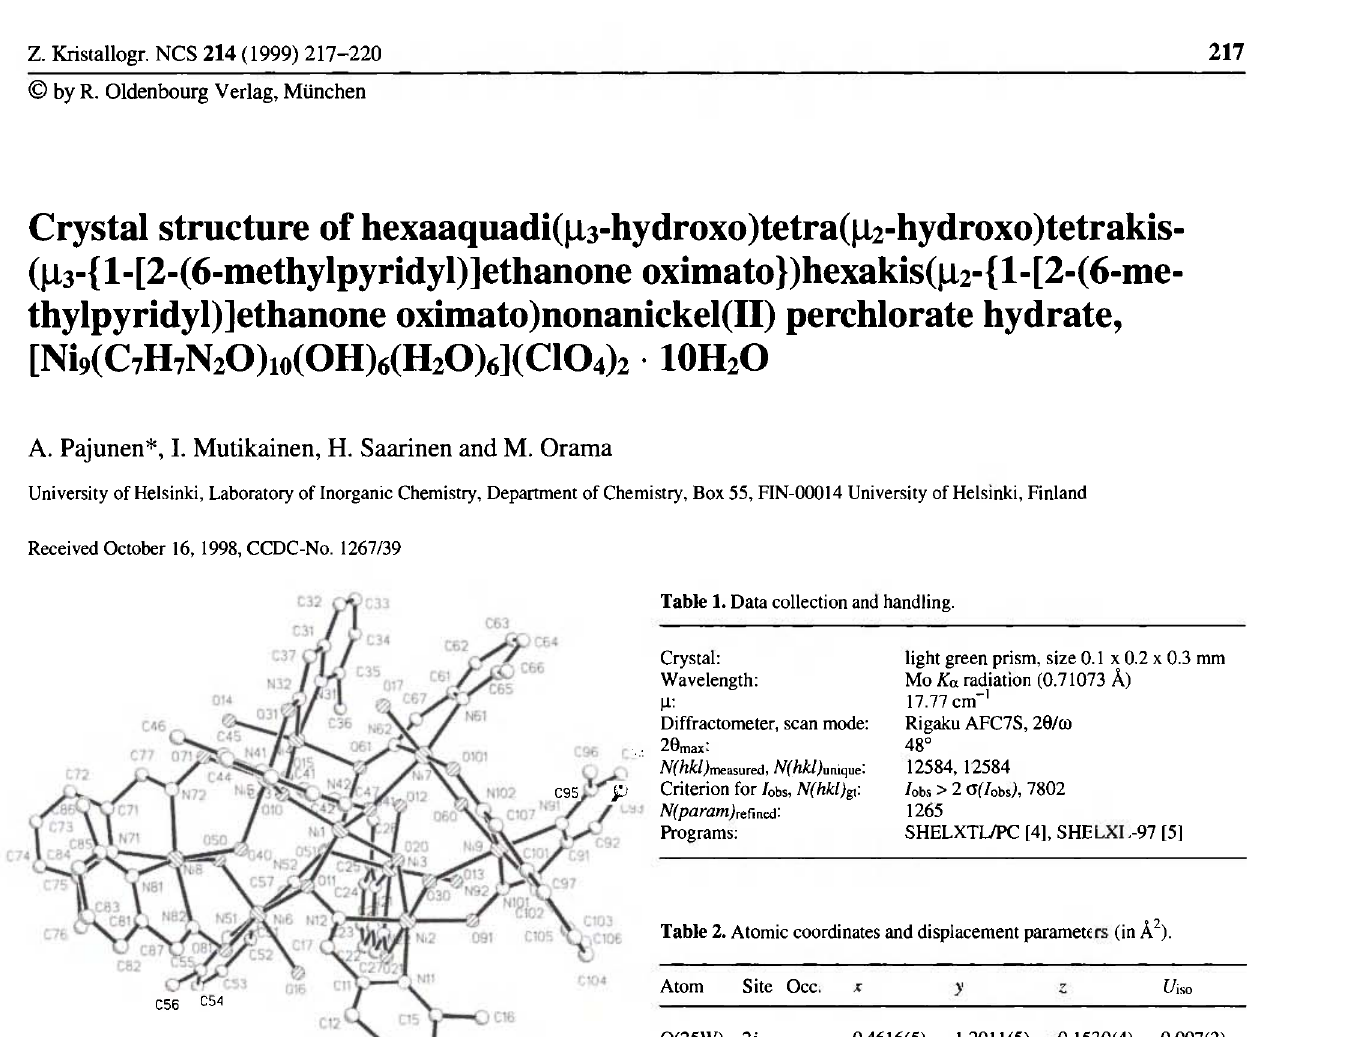
Table 2. Atomic coordinates and displacement